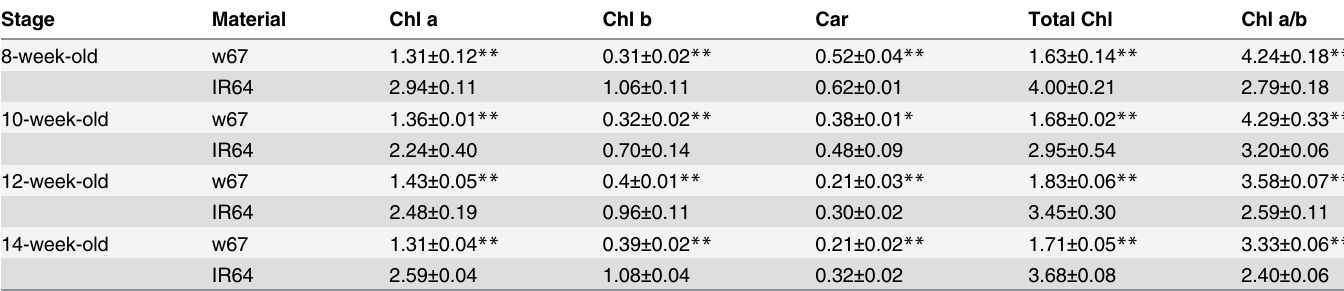
Table 2. The pigment contents in w67 and wild-type IR64 (mg/g fresh weight). Stage